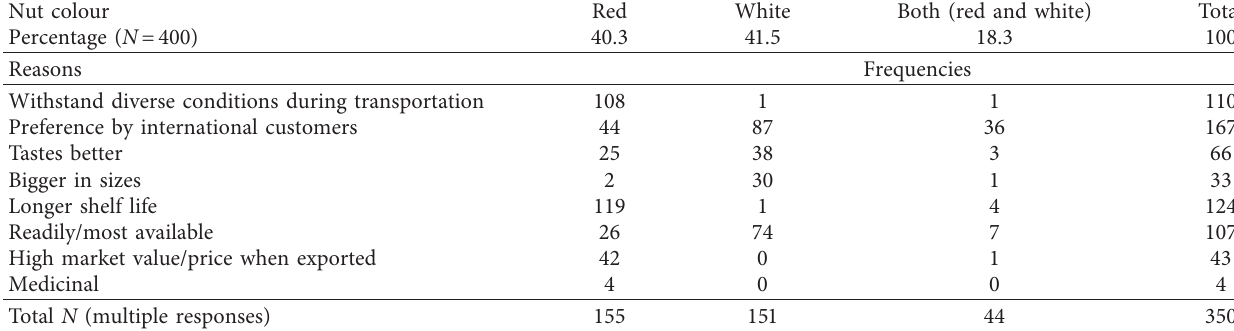
Table 12: Kola nut colour preference and reasons.